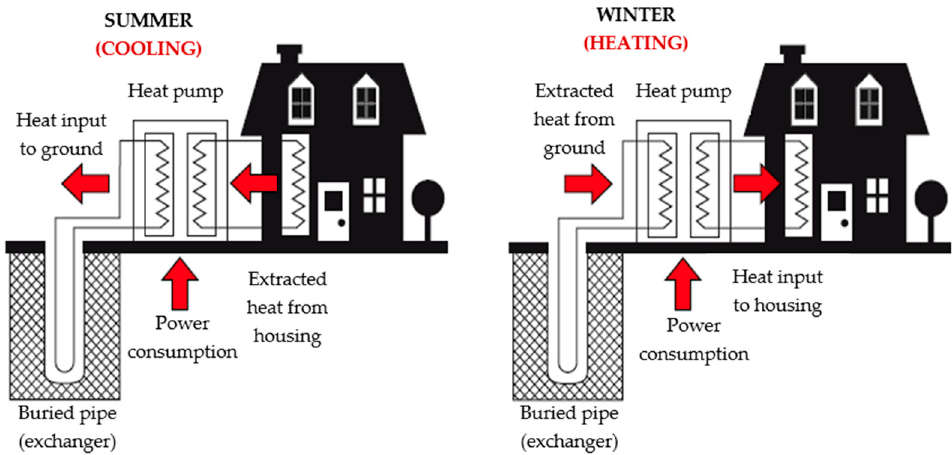
Figure 1. Typical operation of a geothermal exchange system with heat pump.